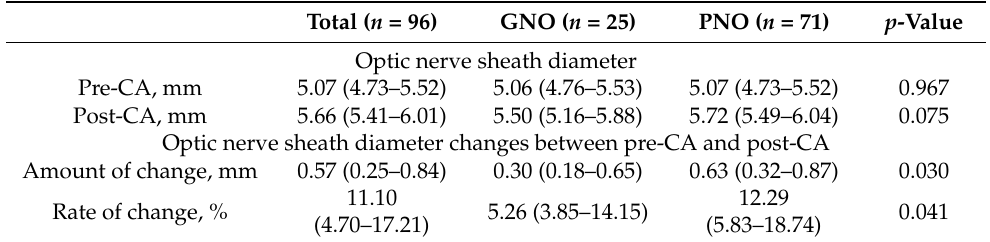
Table 2. The comparisons of the amount and rate of ONSD changes between good and poor neurologic